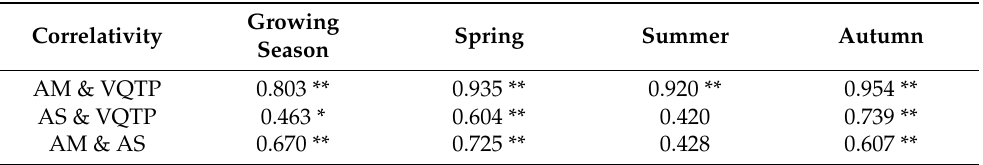
Table 1. Correlation coefficient and significance of the NDVI during different seasons for the AM, AS and VQTP from 2000 to